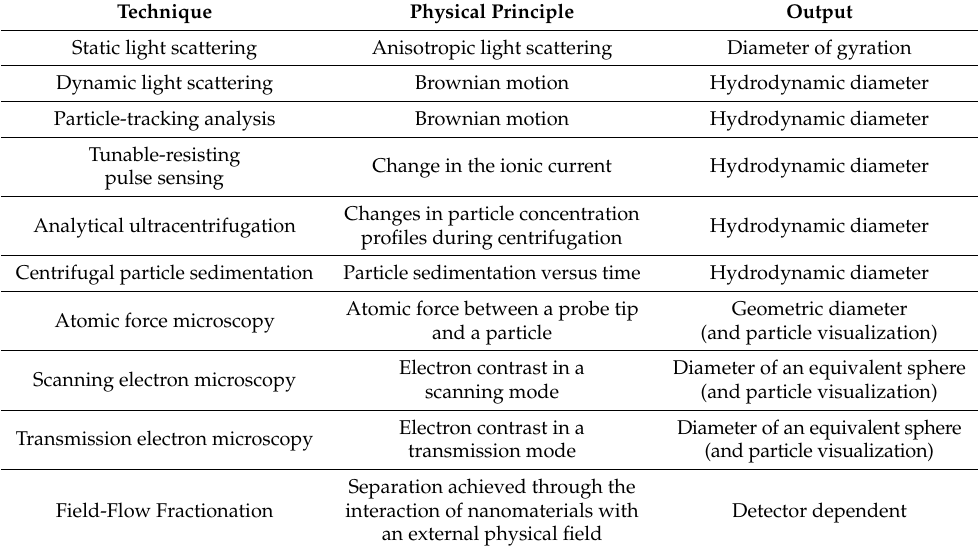
Table 2. Some of the commonly applied techniques in size measurements, corresponding working principles and the type of determined